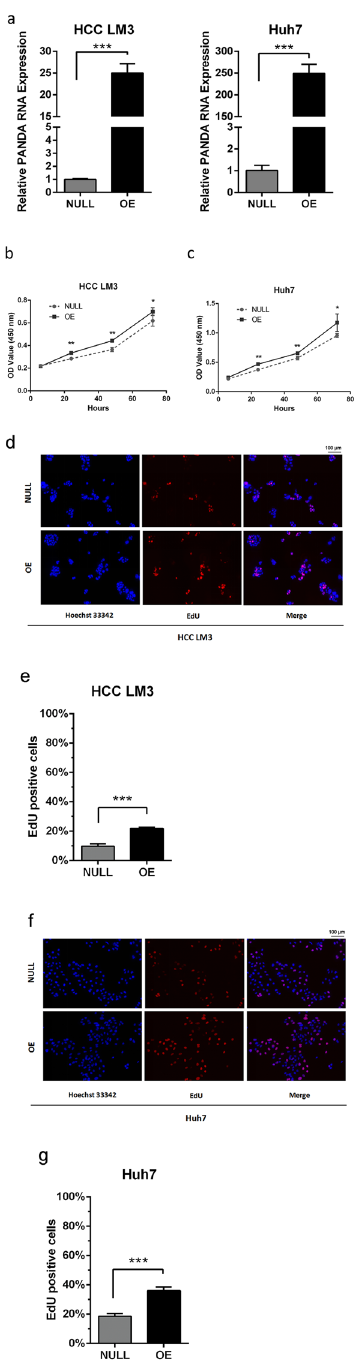
Figure 2. Overexpression of PANDA increases proliferating capacity of liver cancer cells in vitro . ( a ) Effects of overexpression of PANDA in HCC LM3 and Huh7 cells by lentivirus were verified by qRT-PCR. For CCK-8 assay, HCC LM3 ( b ) and Huh7 ( c ) cells with higher expressions of PANDA had significantly elevated OD values (450 nm) at 24, 48, 72 hours. For EdU assay, HCC LM3 ( e ) and Huh7 ( g ) cells with higher expressions of PANDA had more percentage of EdU positive cells. Representative pictures are presented in ( d , f